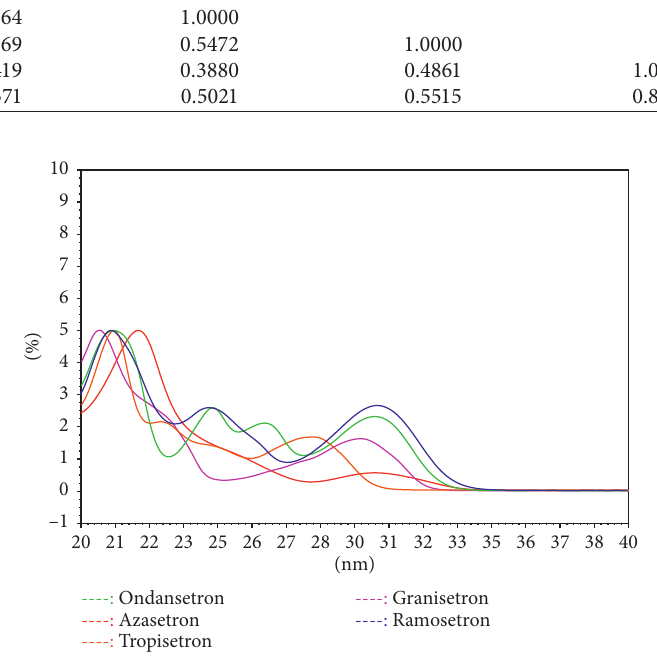
Figure 4: The UV spectra of ODT, GNT, TPT, AZT, and